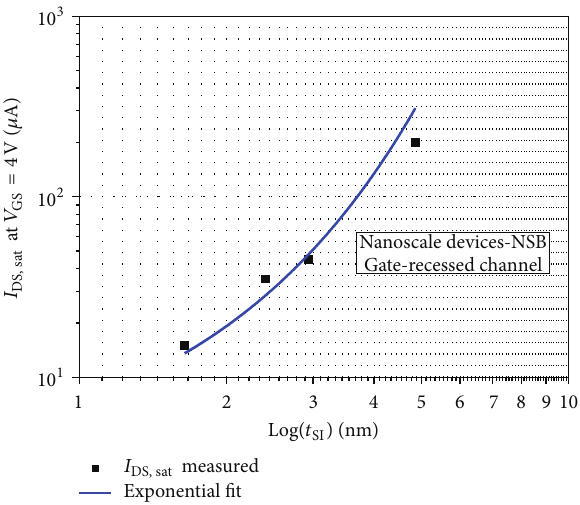
= 4 V and 𝑉 = GS DS